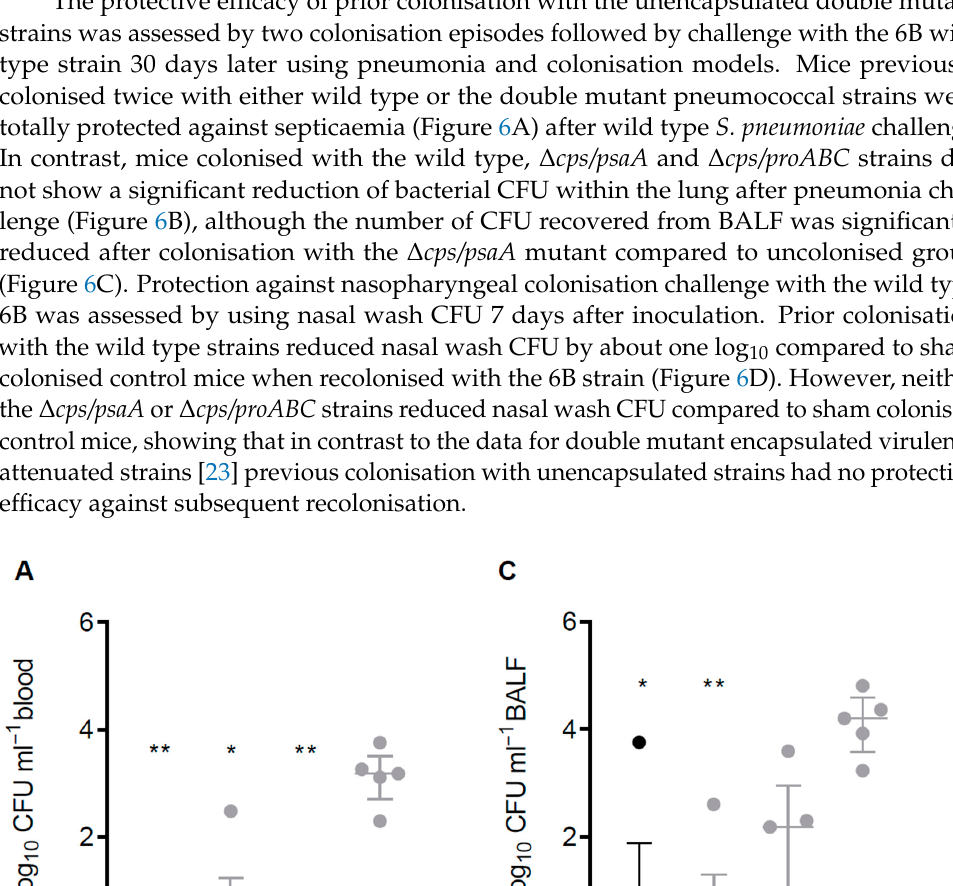
Figure 5. Identification of the protein antigens recognized by IgG in serum from mice colonised with wild type and double mutant S. pneumoniae strains. Antigen specific IgG binding data obtained by probing a protein array containing 254 S. pneumoniae protein antigens with sera from mice colonised twice with the 6B, ∆ cps/psaA , or ∆ cps/proABC strains. ( A ) Heatmap of mean IgG binding levels to the top 16 proteins recognised by IgG in colonised mouse sera ( n = 5 mice). ( B ) Aggregated MFI for IgG binding to the 30 antigens with the highest level of IgG binding in serum from mice colonised twice with the 6B, ∆ cps/psaA , or ∆ cps/proABC strains, or sham colonized with PBS. Each symbol represents data from 1 mouse, bars represent mean and error bars SD. Asterisks represent statistical significance compared to the uncolonised group (Kruskal-Wallis with Dunn’s multiple comparisons posthoc test; ***, p < 0.001). ( C ) Binding results in sera from mice colonised twice with the 6B strain, ∆ cps/psaA , or ∆ cps/proABC strains, or sham colonised to the 6 antigens with the highest level of IgG binding in serum obtained from wild type colonized mice. Each symbol represents data from 1 mouse, bars represent mean and error bars SD. Asterisks represent statistical significance compared to the uncolonised group (two-way ANOVA with Dunnett’s for multiple comparisons, **, p < 0.01; ***, p < 0.001, ****, p <